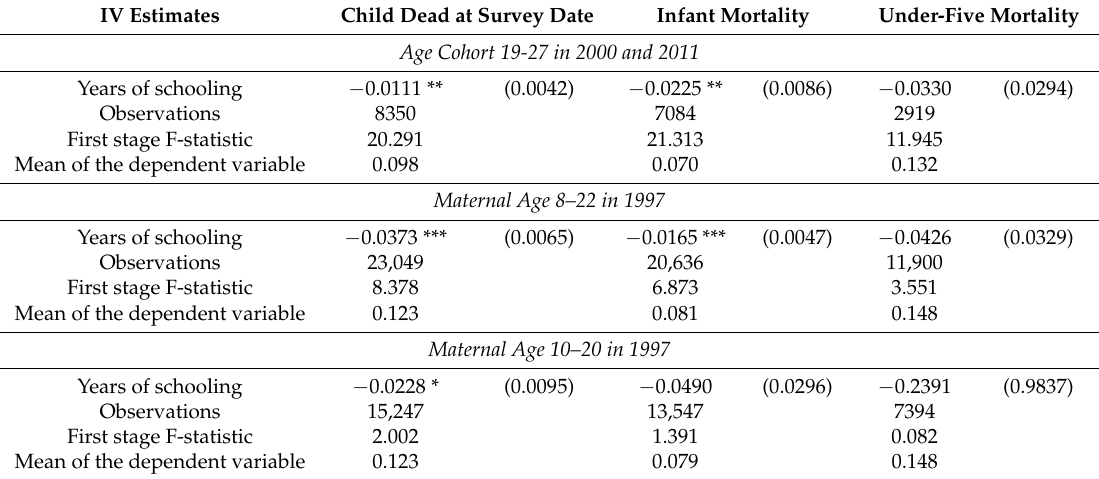
Table 4. Robustness checks—Two stage least squares estimates of the effect of mothers’ education on child mortality